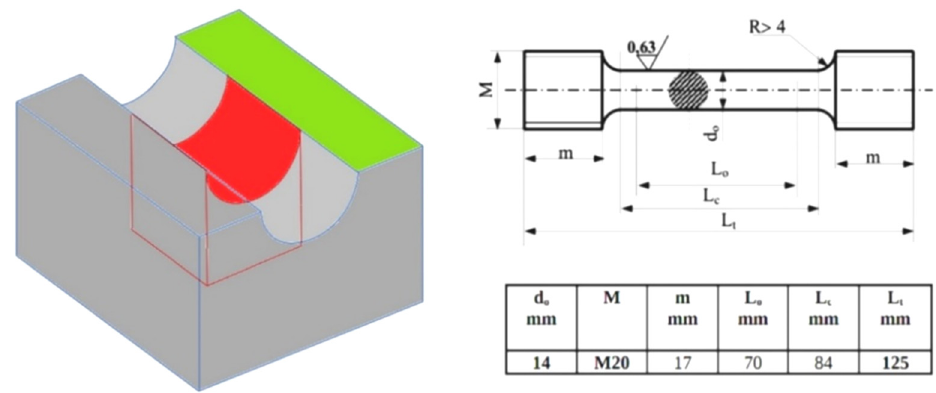
Figure 1. The scheme of the experimental casting with marked sampling site for metallographic (red area) and mechanical properties (green mark) examinations; drawing and dimensions of circular cross-section test pieces on right [5,12,24].